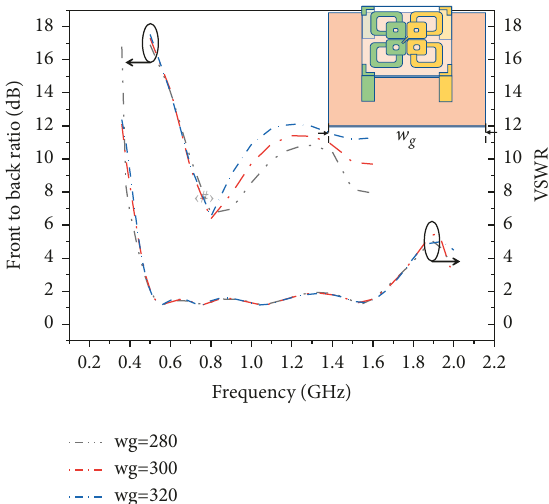
Figure 8: Effect of the ground width (Wg) on the VSWR and the front-to-back ratio.